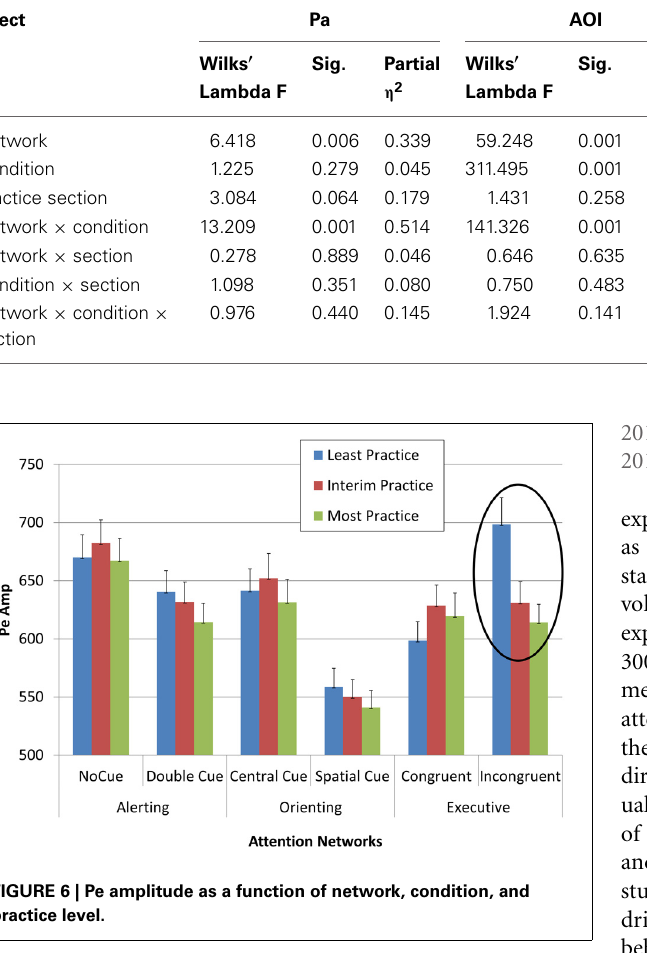
alerting and sustained engagement with stimuli-response contin- gencies necessary for